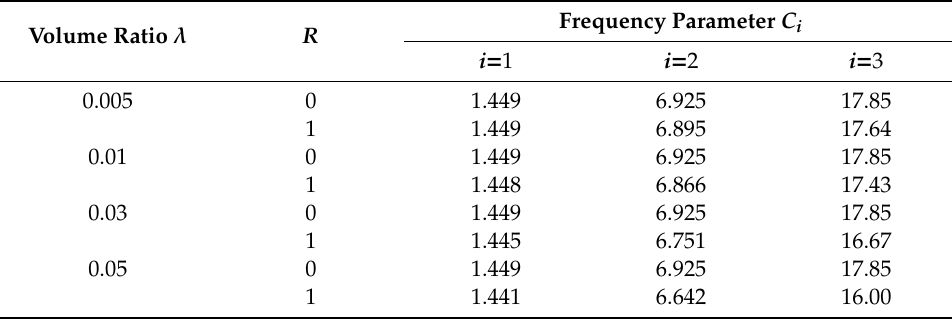
Table 3. E ff ect of rotatory inertia index R on frequency parameter C i by volume ratio λ .